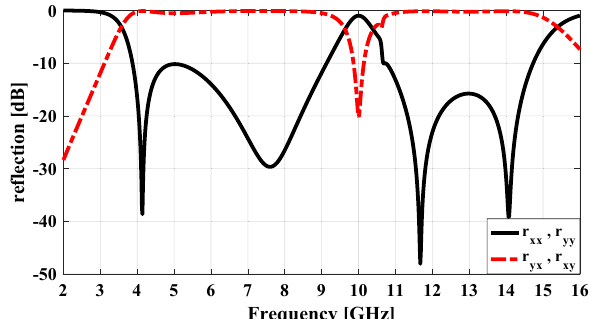
Figure 7. Simulated results of the co- and cross-polarization reflections for proposed unit cell.